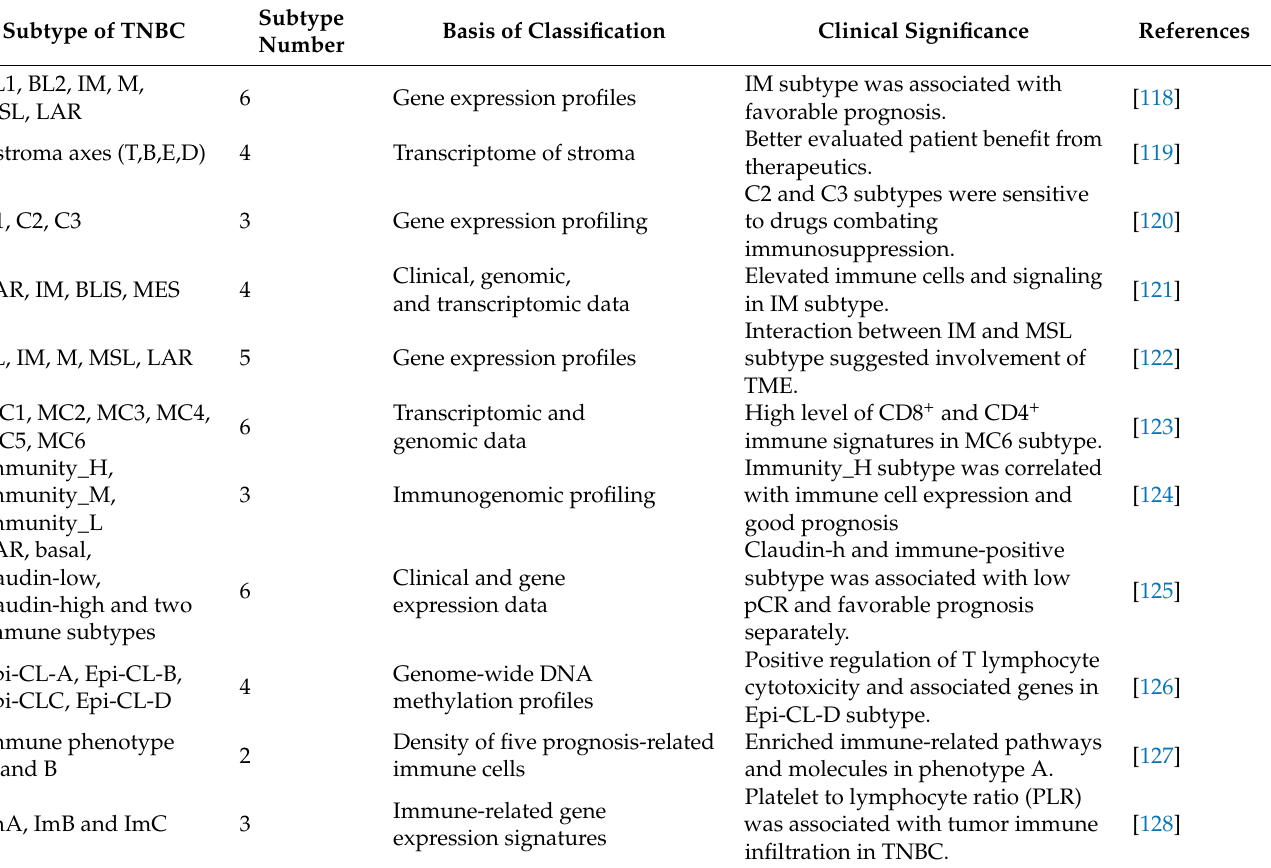
Table 2. TNBC subtype